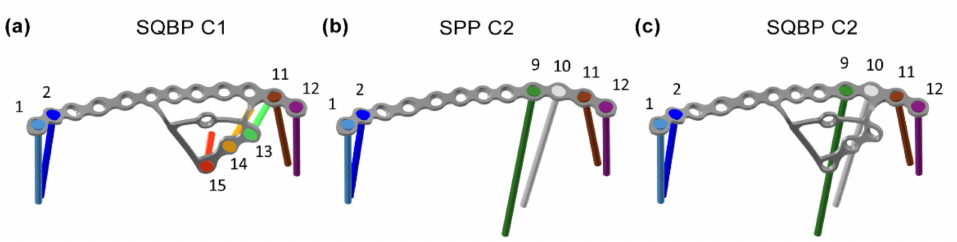
Figure 2. Generated plates geometry assembled with the screws configuration to obtain the three plate-screws models: ( a ) suprapectineal quadrilateral surface buttressing plate (SQBP) C1, ( b ) SPP C2 and ( c ) SQBP